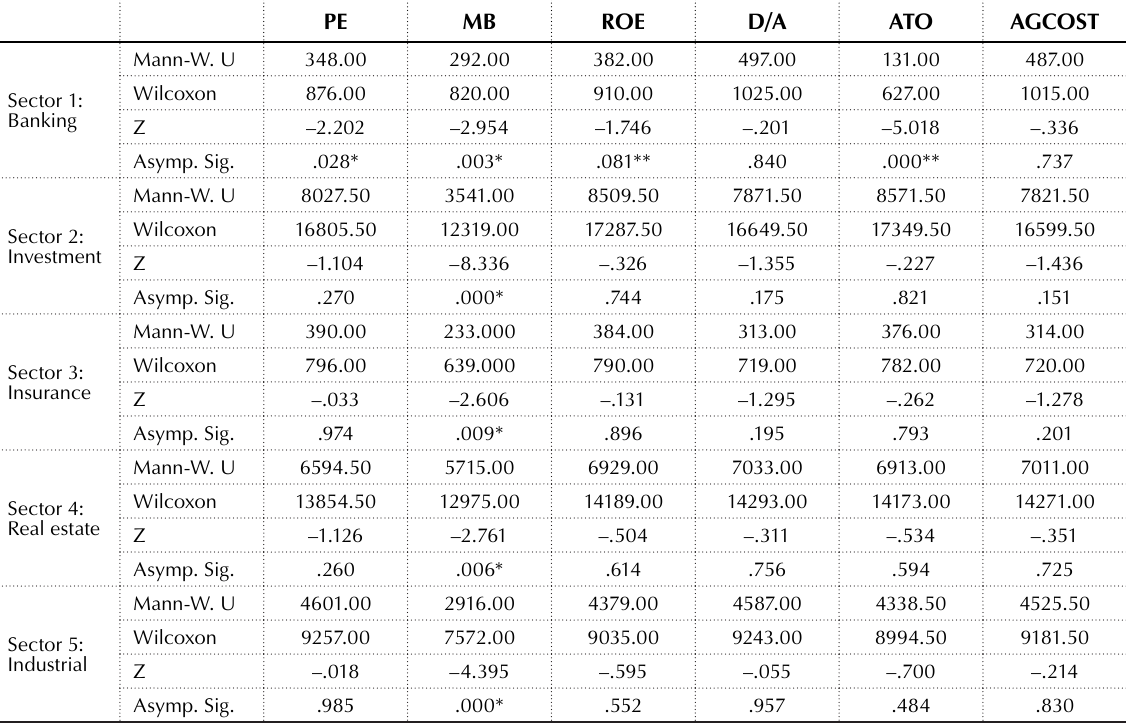
Table 3a. Mann-Whitney U test with CMAL grouping